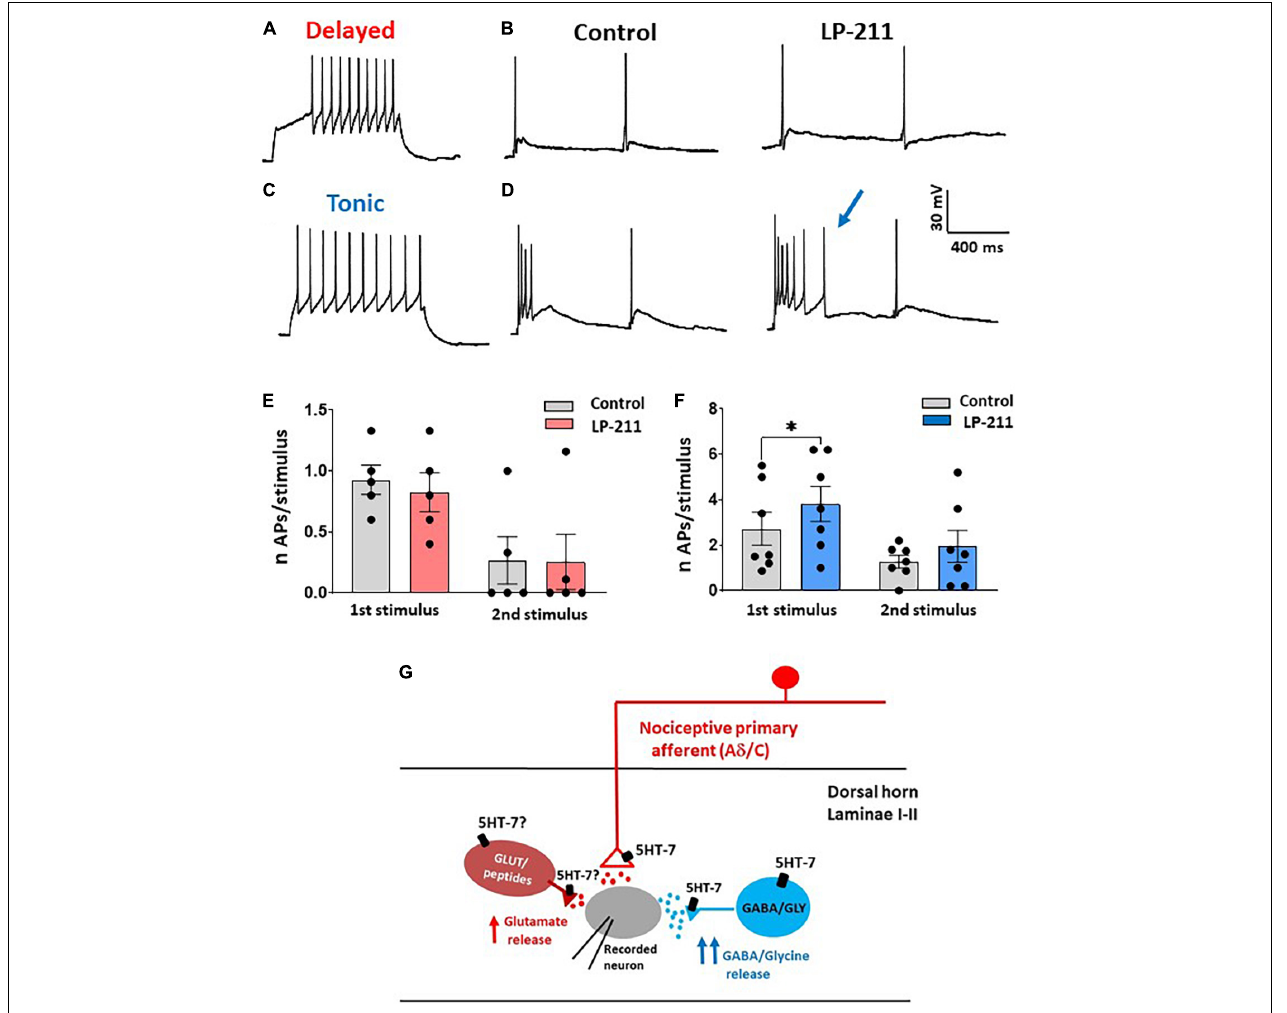
FIGURE 4 | Activation of 5-HT 7 Rs differently affects the excitability of delayed and tonic firing lamina II neurons. (A) Example of a delayed firing neuron, recorded in current clamp at –80 mV. (B) In the same neuron, dorsal root stimulation (2 pulses) evoked action potentials (APs) superimposed to the excitatory postsynaptic potentials (EPSPs). The number of APs was not changed in the presence of LP-211 (1 µ M). (C) Example of a tonic firing neuron, recorded at a potential of about –80 mV. (D) In the same neuron, LP-211 increased the number of APs elicited by root stimulation at the first pulse. (E) The mean number of APs evoked in delayed firing neurons was not changed by LP-211 (first stimulus: paired t -test, p = 0.08; second: paired t -test, p = 0.85, n = 5). (F) In the tonic firing neurons, the number of APs was significantly increased at the first stimulus (first: Wilcoxon rank-sum test, p < 0.05; second: paired t-test, p = 0.2, n = 7). (G) Schematic diagram depicting the hypothetical dorsal horn circuit involved in 5-HT 7 R-mediated synaptic modulation (see section “Discussion”). Asterisks reported in the graphs represent statistical significance: ∗ p < 0.05; ∗∗ p < 0.01; ∗∗∗ p <